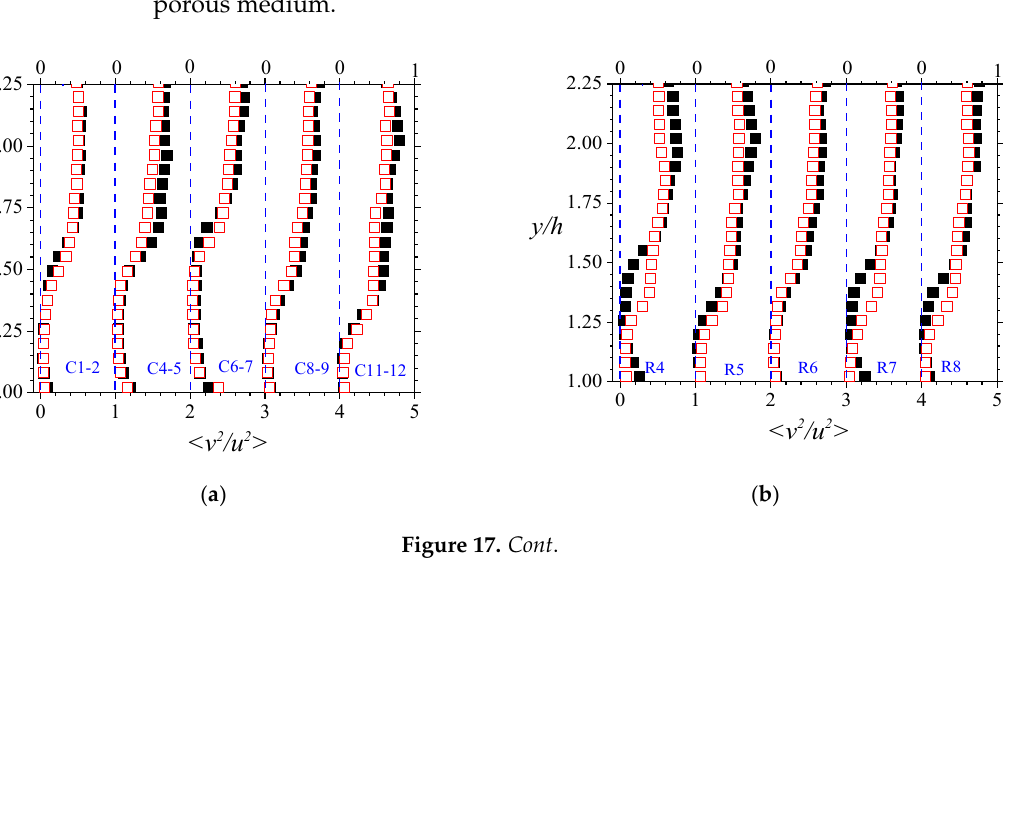
Figure 16. Turbulence quantities < u 2 /U max2 >, < v 2 /U max2 >, and < −uv/U max2 > are respectively line-averaged streamwise Reyn- olds normal stress, wall-normal Reynolds normal stress, and Reynolds shear stress in the streamwise-wall-normal plane, normalized by the local maximum line-averaged streamwise mean velocity in both open and porous regions. Here, the profiles for the flow in the open region are shown. Staggered plots ( a , c , e ) show the streamwise variations whereas ( b , d , f ) demonstrate the spanwise variations. The denominations C and R respectively stand for columns and rows, and are illus- trated in Figure 1. Black-filled boxes are the results for Test A , and red-open boxes are the results for Test B .